Question: What visual encoding does this figure use to show its data?
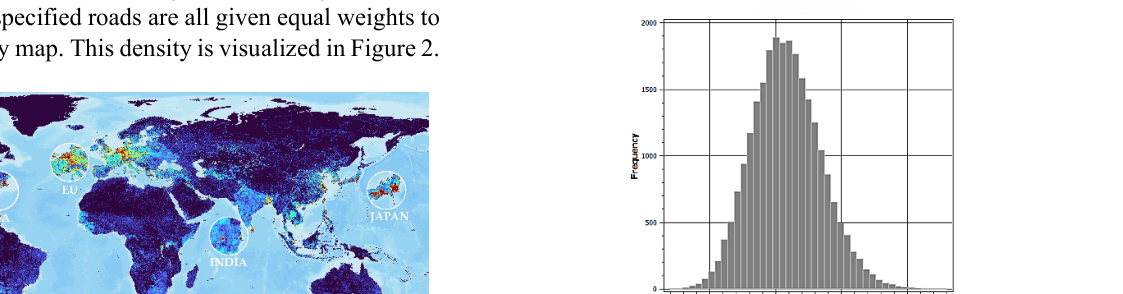
Answer: histogram